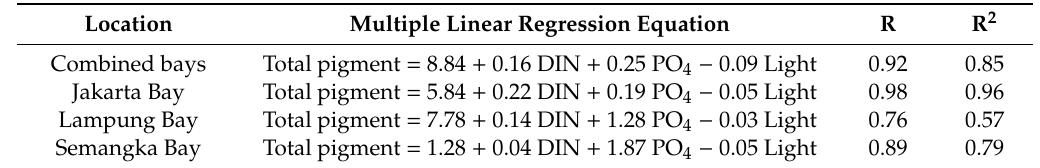
Table 3. Multiple linear regression between nutrients (dissolved inorganic nitrogen and phosphorus) and light to total pigment concentration in all bays